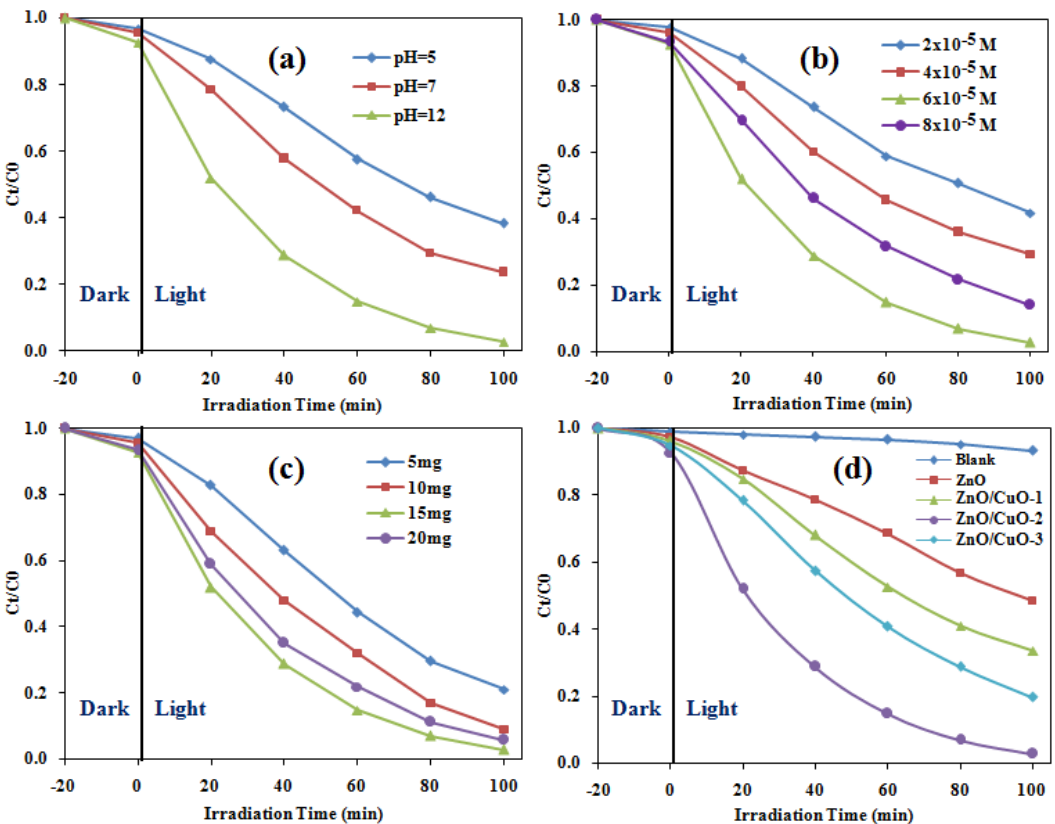
Fig.8. Effect of (a) pH values, (b) initial concentration dye, (c) dosages of photocatalyst, and (d) type of nanocomposites on photodeg- radation of BCB